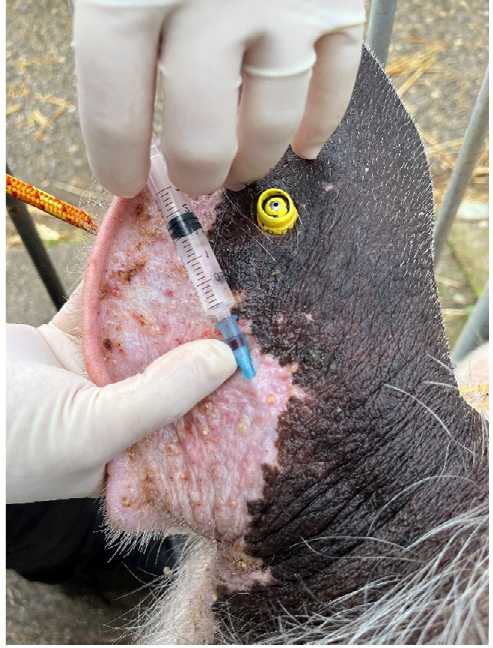
Figure 1. IV access for the administration of anesthetic drugs was achieved through the auricular veins.